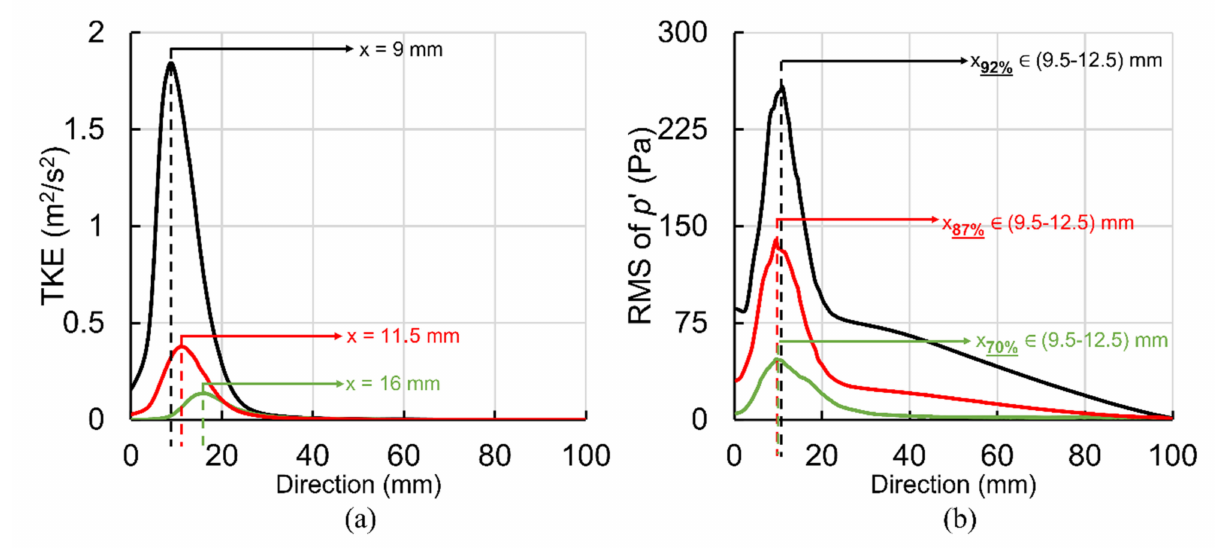
Figure 7. Point of maximum excitation in the post-stenotic region by analyzing ( a ) RMS of pressure fluctuations on the wall and ( b ) turbulent kinetic energy (TKE) on the stenosis centerline.